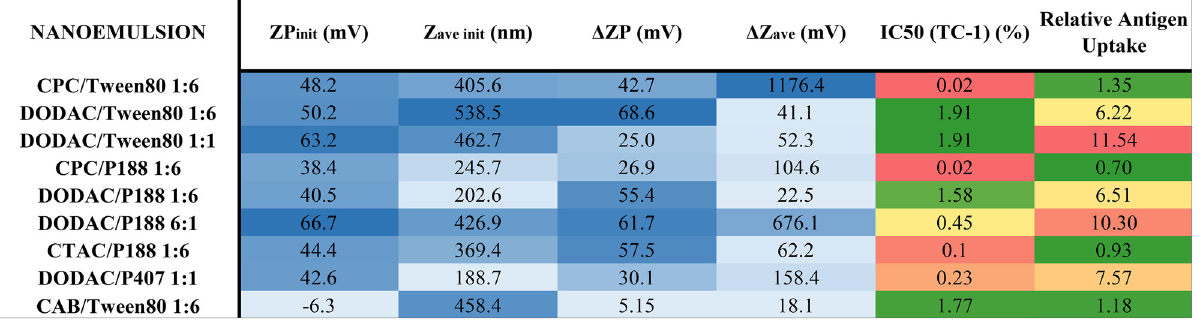
Fig 8. Summary of NE properties and results of in vitro screening assays for NEs selected for in vivo evaluation. Values are colored light to dark blue according to smallest to largest values of ZP init , Z ave init , Δ ZP and Δ Zave with mucin, and green to red for lowest to highest cytotoxicity and relative antigen